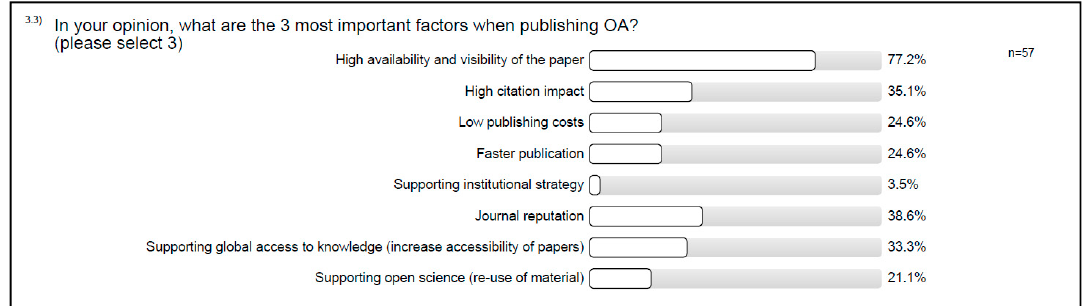
Figure 2. Important factors for publishing OA.